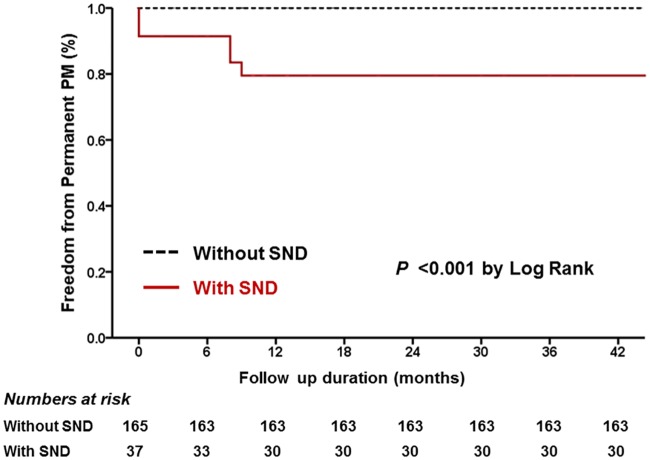
Time to event curves for permanent pacemaker implantation.